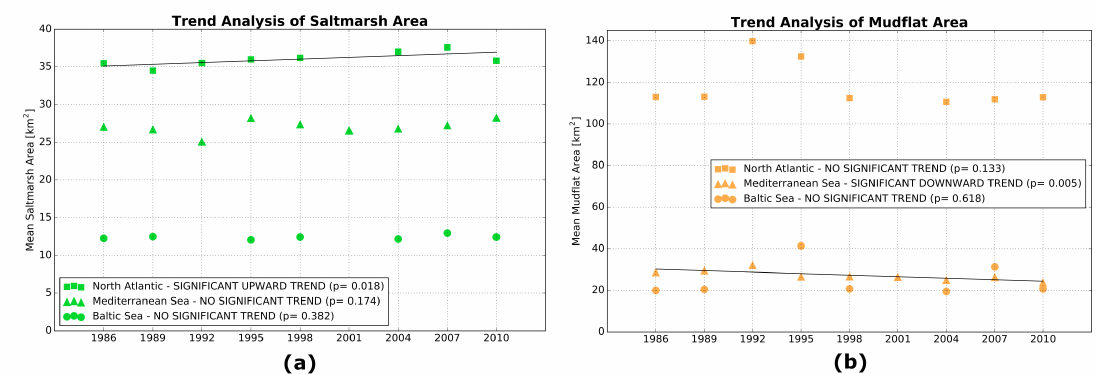
Figure 9. Time series of ( a ) mean saltmarsh area, ( b ) mean mudflat area of the North Atlantic (squares), the Mediterranean Sea (triangles), and the Baltic Sea (circles) with time on the x -axis and mean area (km 2 ) on the y -axis. The straight lines show the slope of significant linear trends detected by the Mann–Kendall trend test with 0.05 level of